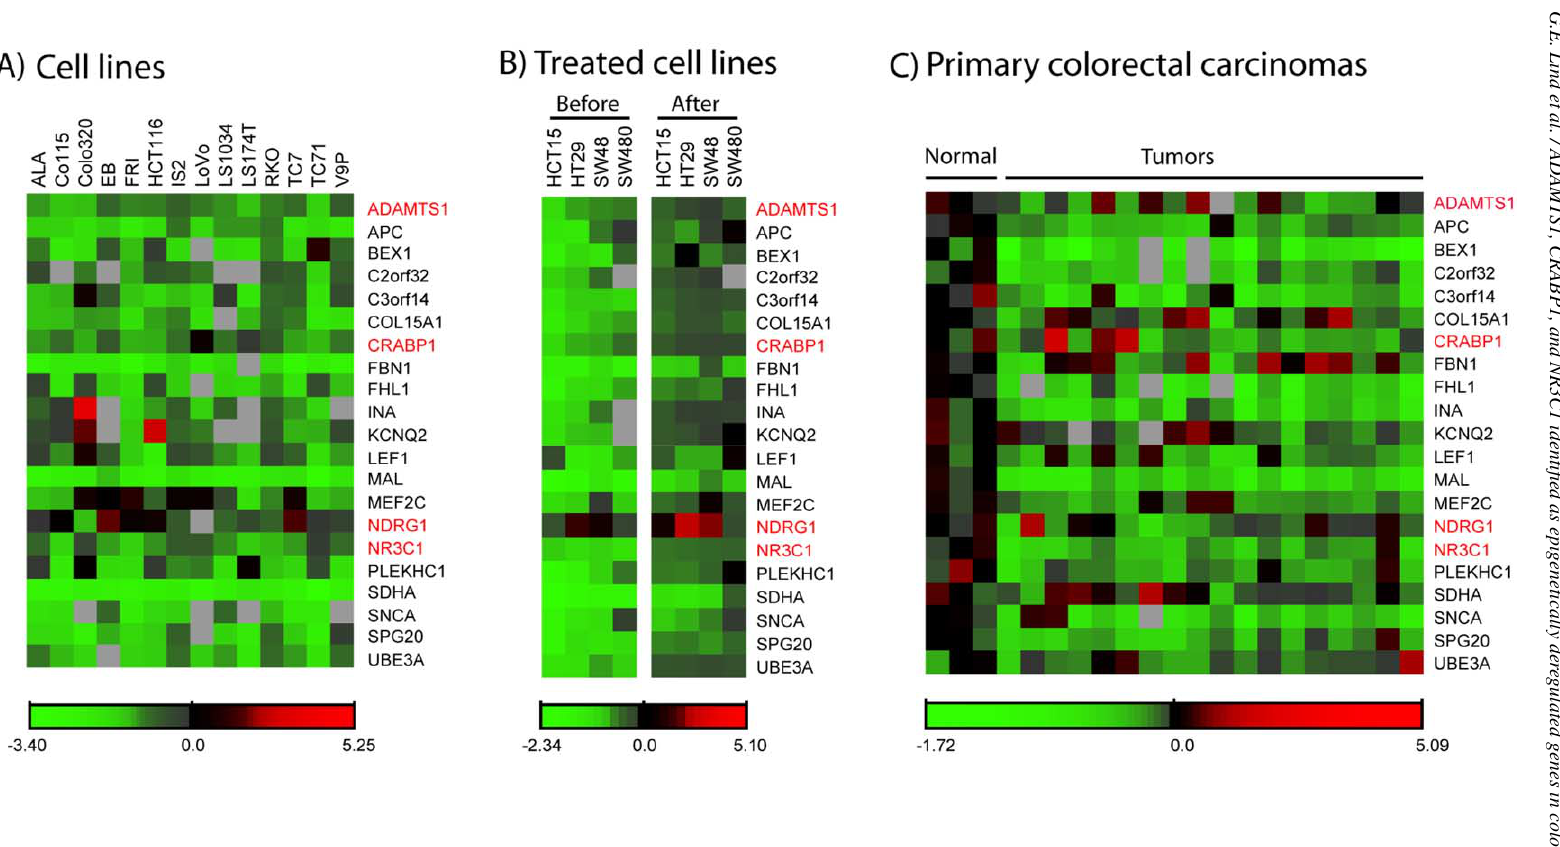
Fig. 1. Gene expression of potential candidates for inactivation by DNA hypermethylation in colon cancer cell lines ( A ), 5-aza-2 (cid:1) -deoxycytidine treated cell lines ( B ), and primary colorectal carcinomas ( C ). The panels illustrate the gene expression in alphabetically order as assessed by microarray analyses. Each ratio is presented by a color for visualization. The gene expression of 21 genes containing a CpG island in their promoter was induced by 5-aza-2 (cid:1) -deoxycytidine treatment in colon cancer cell lines ( B ) and was simultaneously down-regulated in primary colorectal carcinomas relative to normal colon mucosa ( C ). Genes submitted to methylation analyses are highlighted in